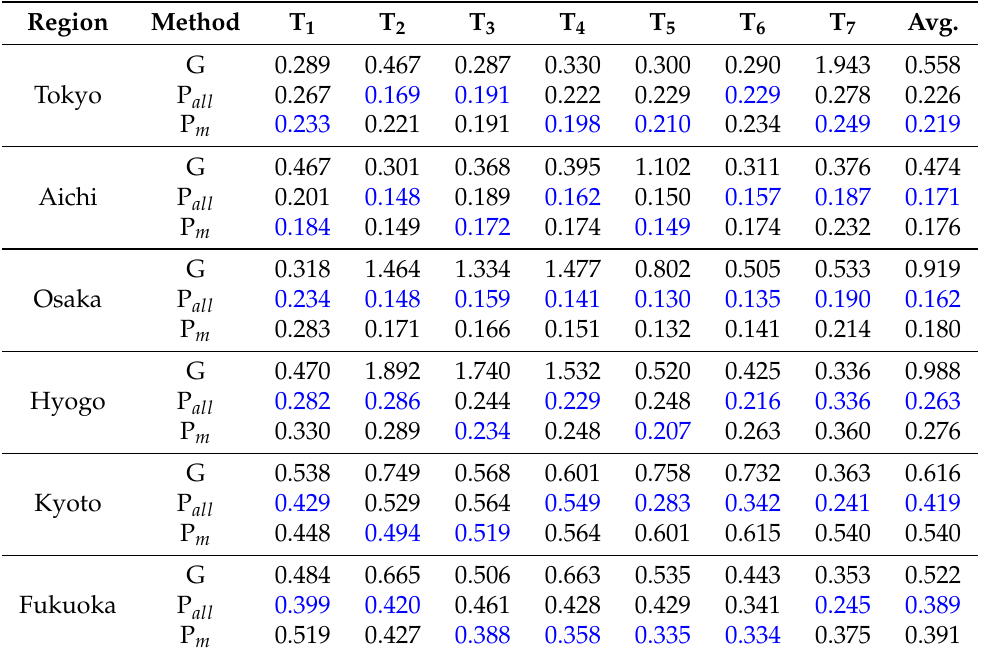
Table 3. Relative error ( E ) computed using different forecasting methods (Google Cloud (G), pro- posed with temperature, humidity, and mobility data (P all ) and proposed with mobility data only (P m )) for all study regions over seven time periods ( T 1 – T 7 ) shown in Figure 5. Blue color indicates the lowest error